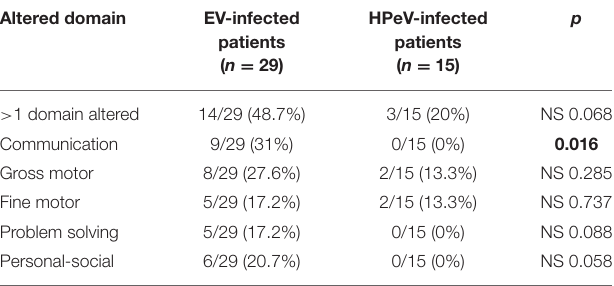
TABLE 3 | First assessment of neurodevelopment in medium-term with the ASQ-3